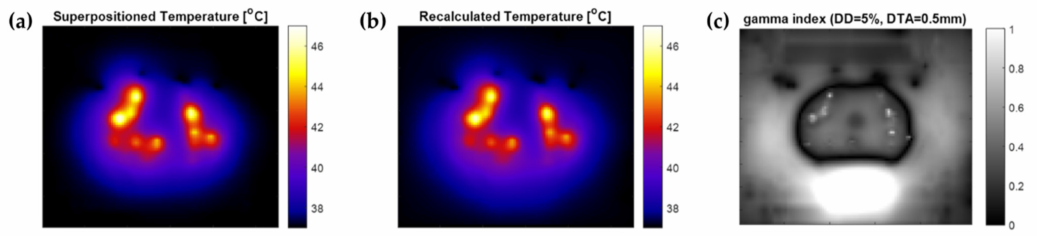
Figure 4. Comparison between superpositioned temperature calculation and FEM recalculation on the central axial slice in the prostate. ( a ) Temperature map using superpositioning of separate FEM calculations for each electrode. ( b ) Temperature map using a single FEM calculation for the same, combined, electrode settings. ( c ) γ -index map of the comparison.